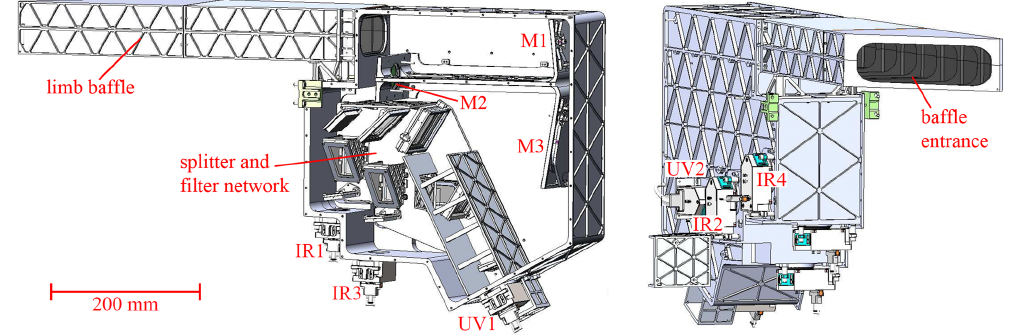
Figure 3. Overview of the MATS limb imager with one of the side covers removed (Hammar et al., 2018). Marked in the image are the telescope mirrors M1–M3, as well as the CCDs IR1–IR4 and UV1–UV2 for the six spectral channels.